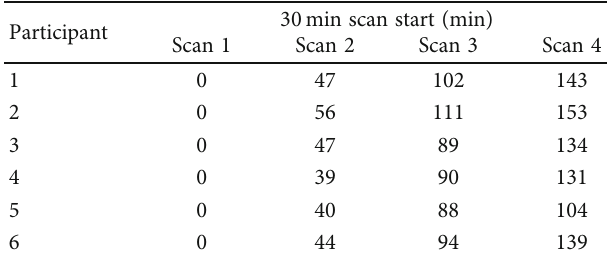
Table 2: Imaging time